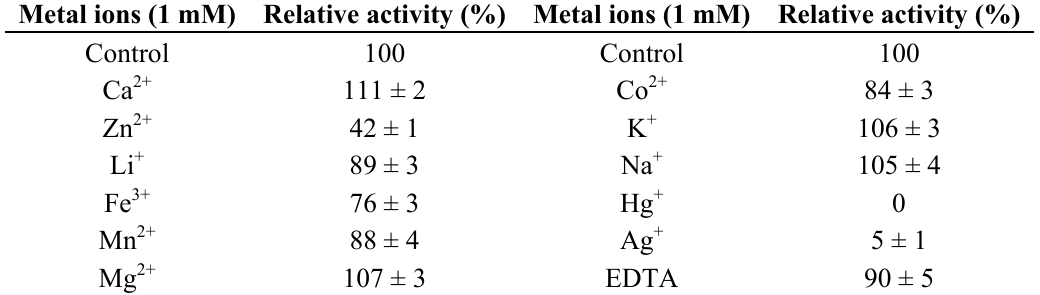
Table 2. Influence of various metal ions (1 mM) on the activity of rProROL. The effect of metal ions on lipase activity was analyzed by incubating enzyme samples for 6 h at room temperature in 50 mM Tris-HCl buffer (pH 8.0), containing 1 mM of metal ions. The activity was measured with a pH-stat (Metrohm, Herisau, Switzerland) and using olive oil as substrate at pH 9.0, 40 °C. The activity of rProROL was determined in the buffer with no addition of metal ions and set as 100%. All measurements were carried out in